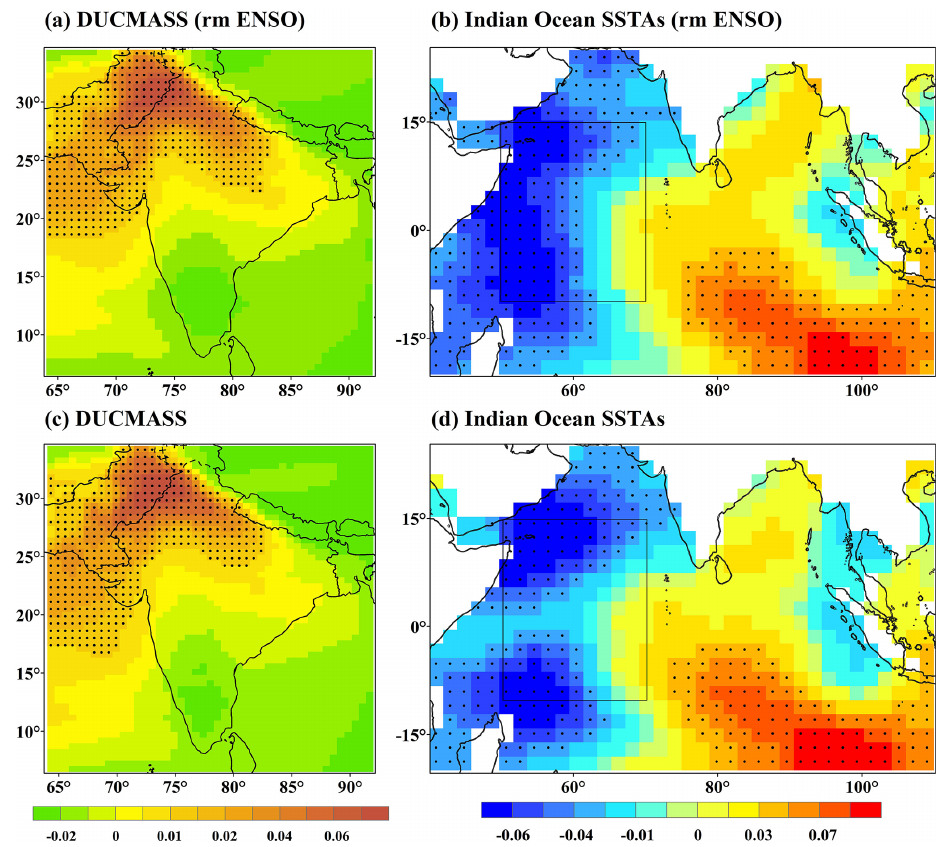
Figure 11. Spatial correlation between summer (June–July) tropical Indian Ocean SSTA (TWISSTA) and DUCMASS of the first mode of the MCA analysis in 1982–2014. The first MCA mode of (a) the DUCMASS and (b) summer (June–July) tropical Indian Ocean SSTA with ENSO-related signals removed. (c–d) As in (a) – (b) but for the original series including the ENSO signal. The black dots represent significance at the ≥ 90% confidence